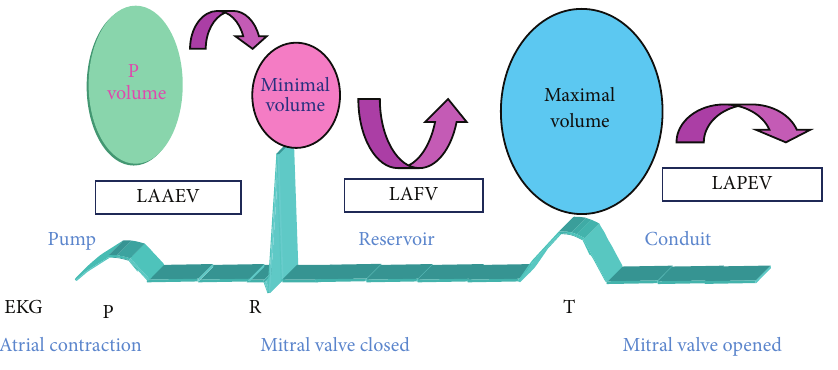
Figure 2: Three different atrial volumes during cardiac cycle.